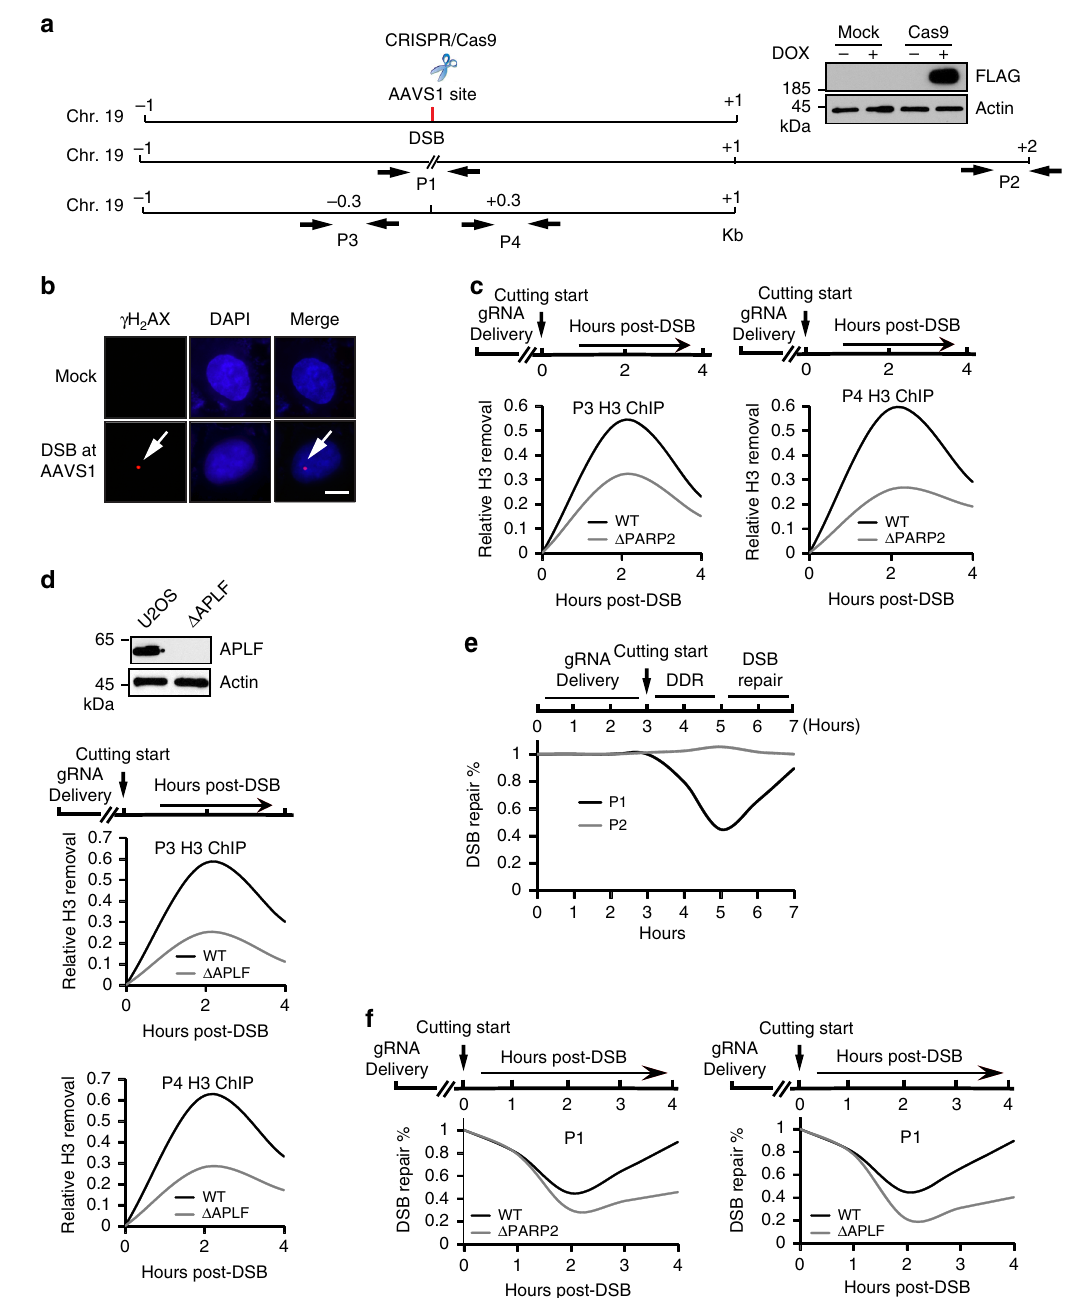
Fig. 6 PARP2-dependent branched PAR chain is important for histone H3 removal in response to DNA damage. a Doxycycline (DOX)-inducible Cas9 (iCas9) was expressed in the U2OS or U2OS PARP2-null cells. The expression of iCas9 was examined by western blot using anti-FLAG antibody (monoclonal antibody, Sigma F1804, the inset). A gRNA facilitates a single DSB as the AAVS1 locus. P1 represents a pair of primers fl anking both sides of the DSB for the analysis of DSB repair. P2 is a pair of primers speci fi c to a region 2 kb upstream to the DSB and serves as a negative control of DSB repair. P3 and P4 are two sets of primers located at 0.3 kb upstream and downstream respectively from the DSB. These two primers were used for the detection of histone H3 removal in response to DNA damage. b γ H 2 AX (polyclonal antibody, Abcam ab11174) was examined as a surrogate maker of the solo DSB at AAVS1 locus using immuno fl uorescence analysis. c Histone H3 removal is severely compromised in the absence of PARP2. Histone H3 removal was examined by ChIP assays with antibody (polyclonal antibody, Millipore 06-755) using P3 and P4 primers. d Depletion of APLF also suppressed histone H3 removal at the DSB. Depletion of APLF was veri fi ed by western blot using anti-APLF antibody (polyclonal antibody, Thermo Fisher Scienti fi c PA5-39776, left panel). e DSB repair was monitored by q-PCR using P1 and P2. f Loss of either PARP2 or APLF signi fi cantly suppresses DSB repair. DSB repair in cells lacking PARP2 or APLF was examined by q-PCR. Scale bar represents 5 μ